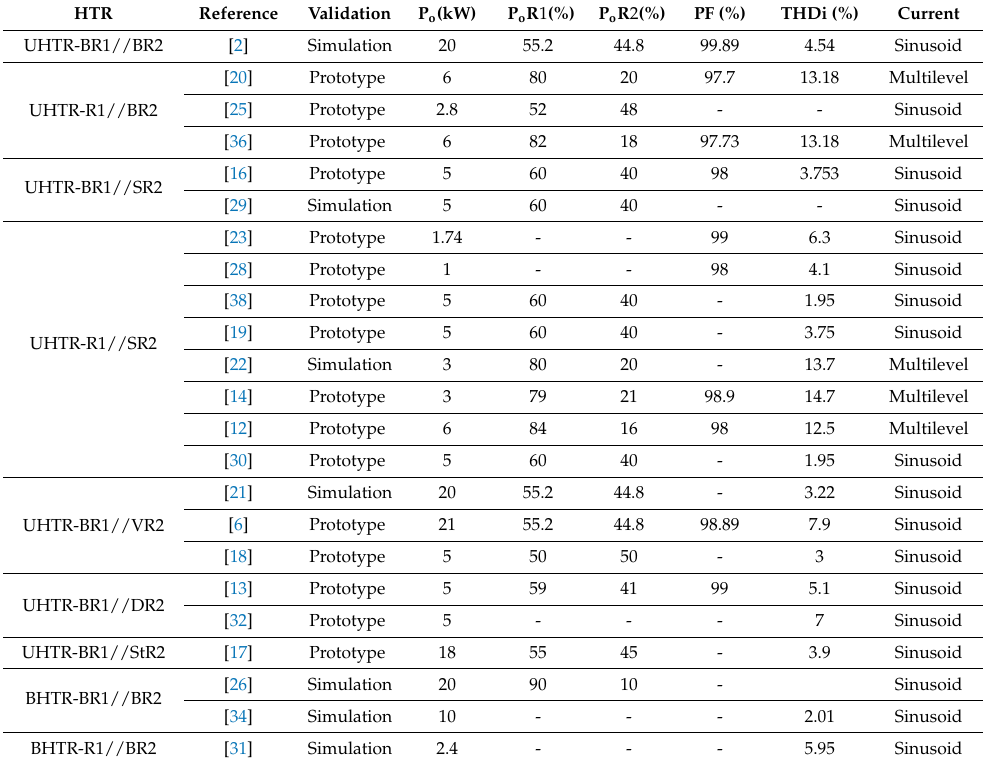
Table 7. PF and THD in